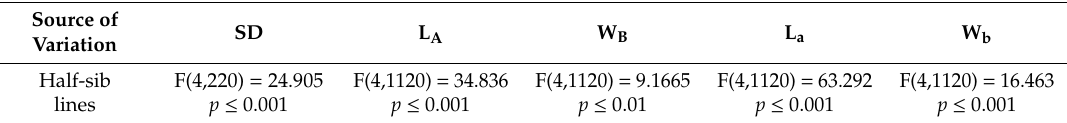
Table 3. Results of the analysis of variance for measured stomatal traits of the studied Q. robur half-sib lines.